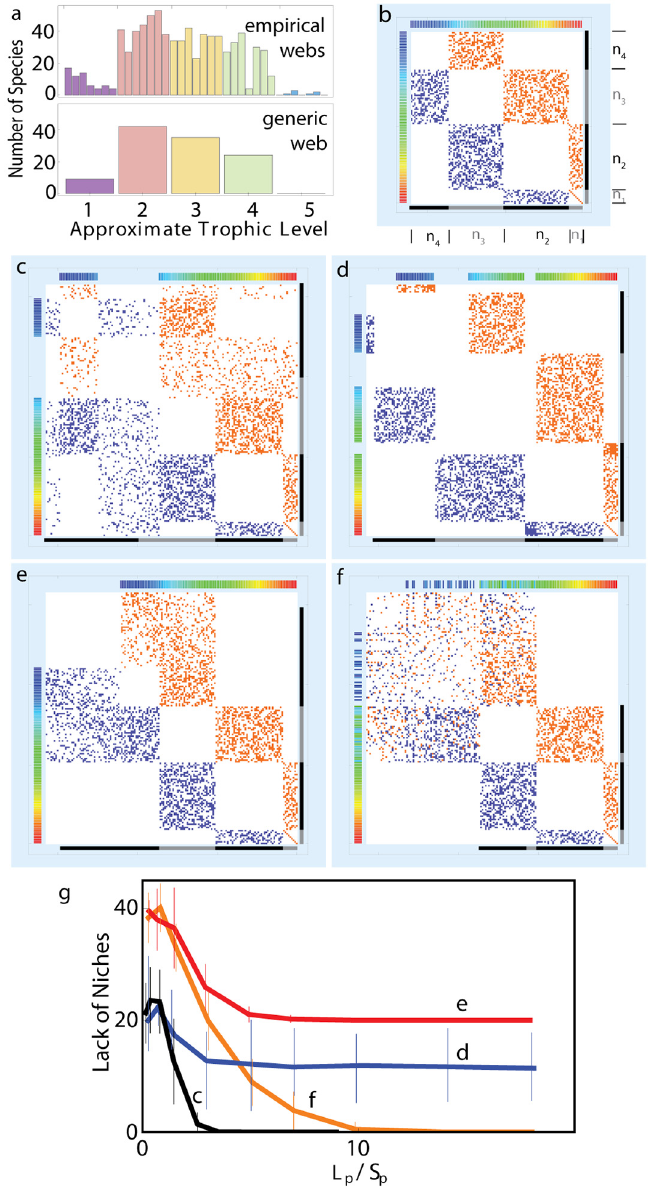
Fig 6. Simulations of different food web matrices. a , Barplots indicate distributions of node richness for each approximate trophic level in the seven empirical foodwebs and a generic foodweb derived by averaging the empirical node richnesses in each trophic level. b , Interaction matrix corresponding to the generic food web, containing 110 free-living and 47 parasite species (Details: Methods and Sec. S10 in S1 Text). c , Addition of parasites that form random links to any existing free-living species. d , Addition of parasites that are confined to consumer at a specific trophic level. e , Similar to (c) but with the restriction of parasites consuming only free-living species at levels 3 and 4. f , Similar to (e) but with additional parasite-parasite interactions (hyperparasitism), approximately 5 percent of parasite links are from parasite to parasite. Note the color coding along the edges of the matrices in (c) — (f), chosen as in Fig 5a, 5d and 5e. g , The lack of niches, i.e. rank deficiency, as a function of the number of links per parasite for each of the four cases described in (c) —